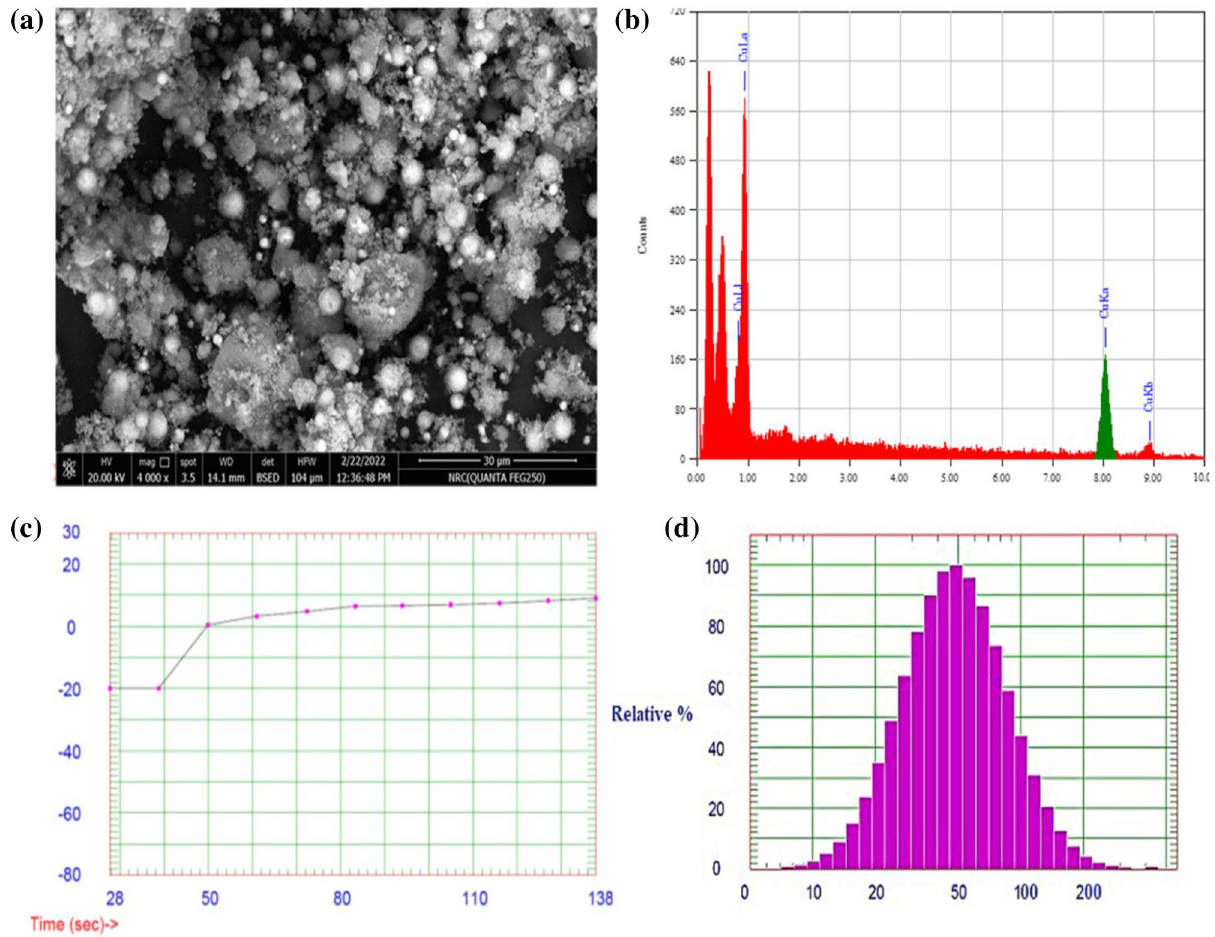
Figure 7. Full characterization of prepared CuO-NPs., ( a ) SEM micrograph (image scale 10 µm, original magnification of 7,000 × and applied voltage of 20 kV), ( b ) EDX analysis, ( c ) zeta potential, and ( d ) particle size